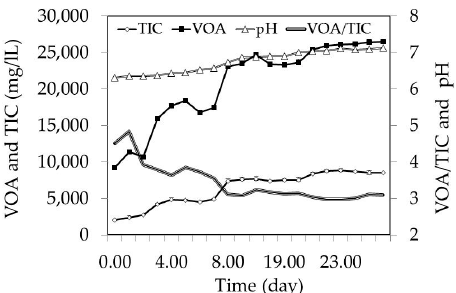
Figure 3. Changes in the DSW mixture during hydrolysis and fermentation. Values for total inorganic carbon (TIC), volatile organic acids (VOA), and pH were augmenting while the ratio VOA/TIC declined during 30 days of hydrolysis and fermentation.